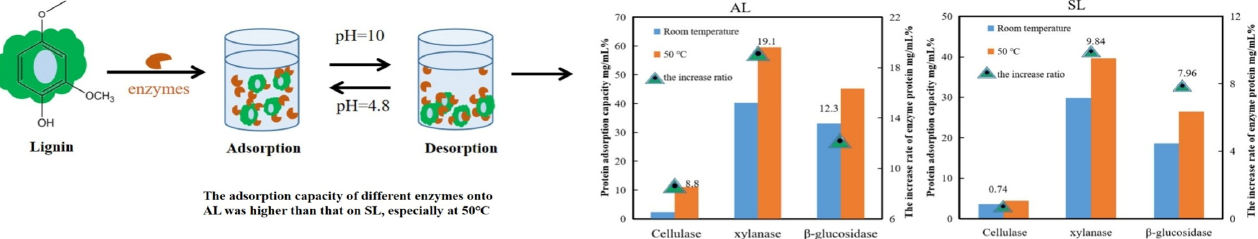
Figure 5. Using eucalyptus lignin as raw material, the dynamic adsorption differences in different enzymes and enzyme components were studied, and the effect of lignin on the enzymatic activities of different enzymes and enzyme components was determined; adapted from [54].